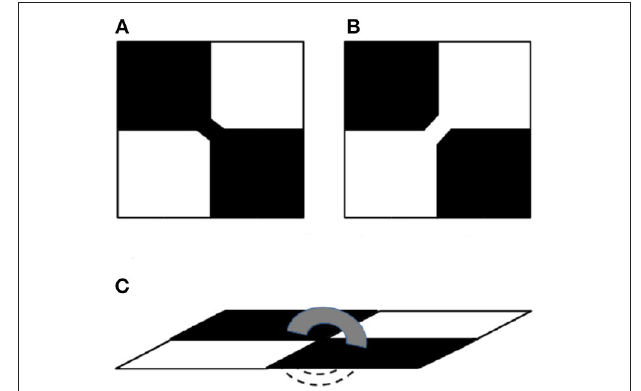
FIGURE 1 | Possible diagonal connections in a 2 × 2 square lattice having two diagonally opposite black pixels (squares) and two diagonally opposite white pixels which orthogonally neighbor them. (A) shows a diagonal connection between two diagonal black pixels (squares) which disconnects the orthogonally neighboring white pixels while (B) shows the reverse situation where two diagonal white squares are connected. In case both are connected, as in (C) , the system becomes quasi